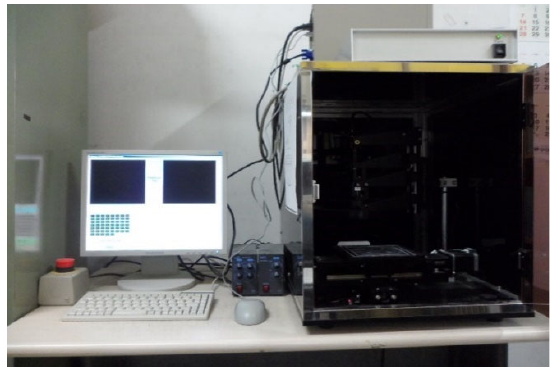
Figure 5. Image analysis device (HF-MA C01). Table 7. Independent and dependent variables and their